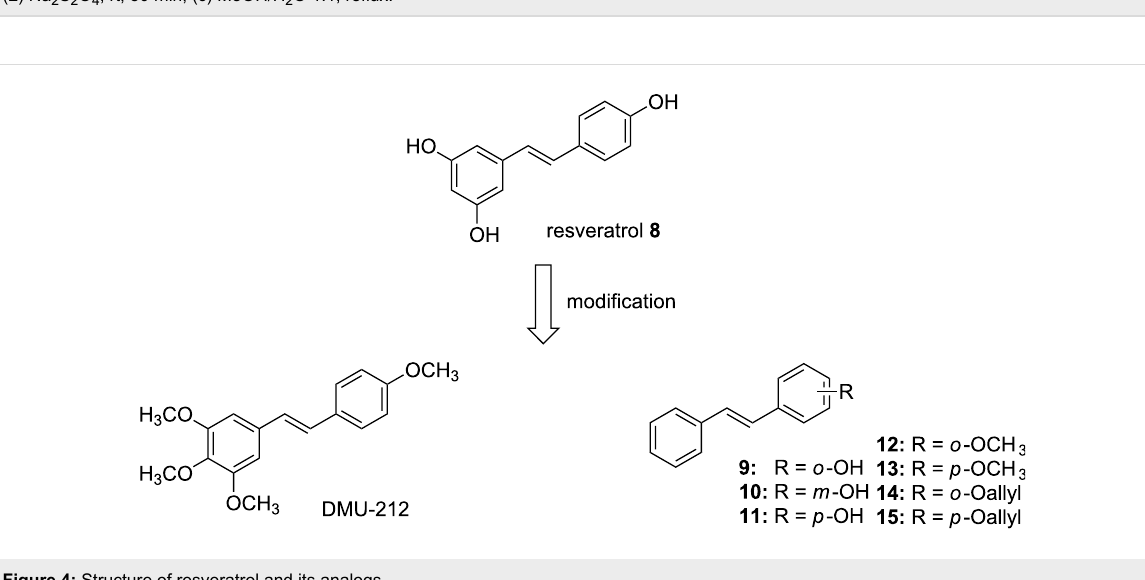
Scheme 3: Synthesis of ellagic acid ( 7 ). Reagents and conditions: (a) H 2 SO 4 , CH 3 OH; (b) (1) o -chloranil, Et 2 O, − 40 °C; − 40 °C → rt, 3 h; (2) Na